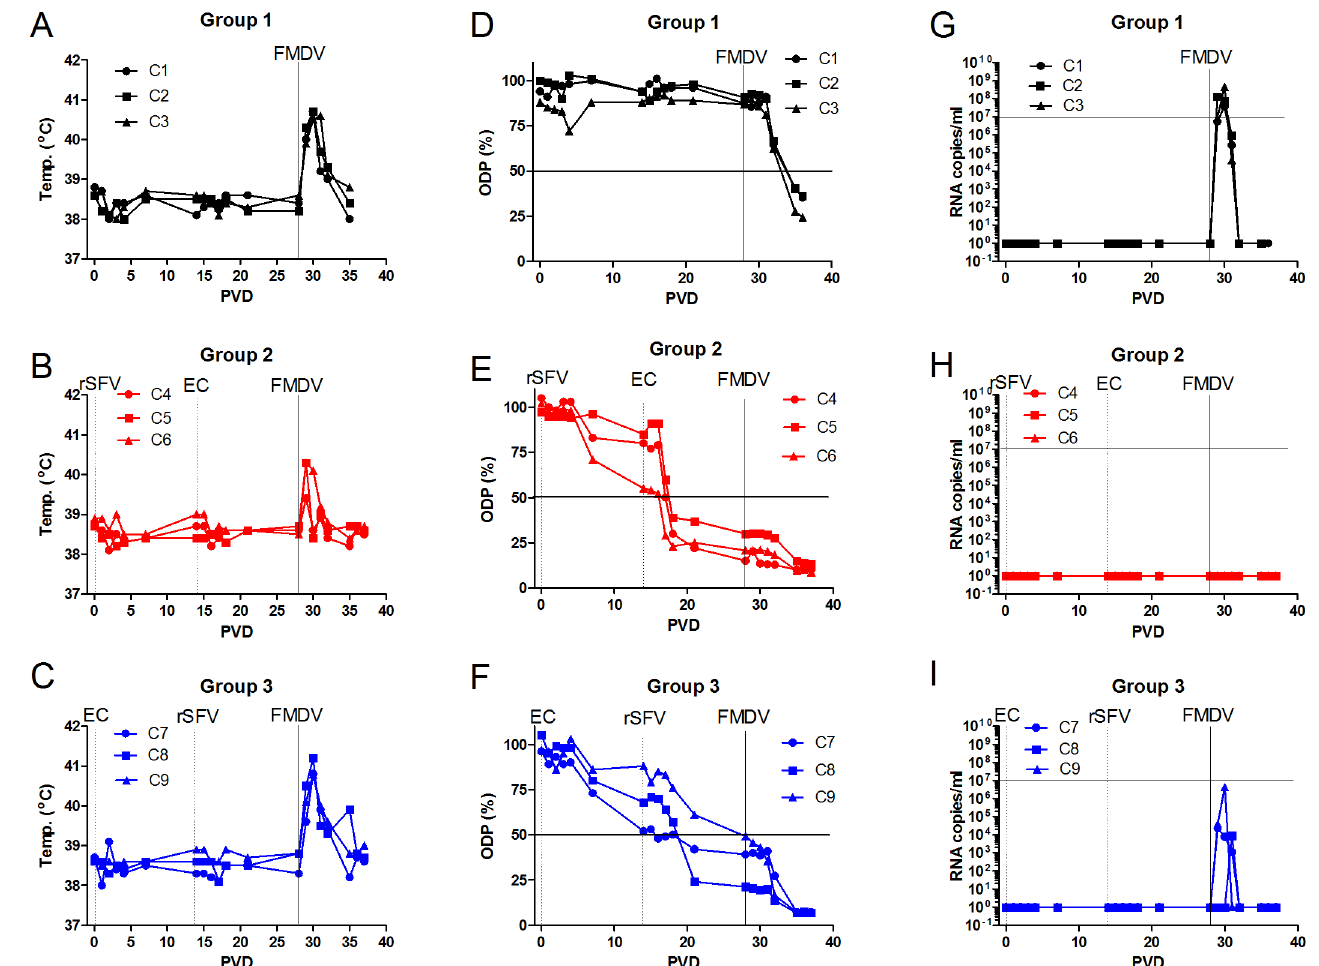
Fig 6. Prime-boost vaccination strategy effectively induces anti-FMDV antibodies in cattle and blocks virus circulation post-challenge. In experiment 3, calves in group 1 (panels A, D, G) were unvaccinated. Calves in group 2 (panels B, E, H) were vaccinated with rSFV-FMDV-P1-2A- mIRES-3C on PVD 0 (dotted vertical line, marked rSFV) and then with O1 Manisa empty capsid particles on PVD 14 (dotted vertical line, marked ECs). Calves in group 3 (panels C, F, I) were vaccinated with O1 Manisa empty capsid particles on PVD 0 (dotted vertical line, marked ECs) and then with rSFV-FMDV-P1-2A-mIRES-3C on PVD 14 (dotted vertical line, marked rSFV). All animals were challenged with FMDV (O UKG/34/2001) on PVD 28 (indicated by solid vertical line, marked FMDV). Body temperatures in each animal were monitored on a daily basis (panels A-C). Sera were collected from each calf on the indicated days and assayed in the serotype O blocking ELISA (panels D-F). Results are presented as ODP (%) with a cut-off value of 50% (indicated by horizontal line). The presence of FMDV RNA circulating in serum was assayed by RT-qPCR (panels G-I). The results are presented as copies of FMDV RNA/ml of serum as in Fig 5. A level of 10 7 copies/ml is indicated by a horizontal